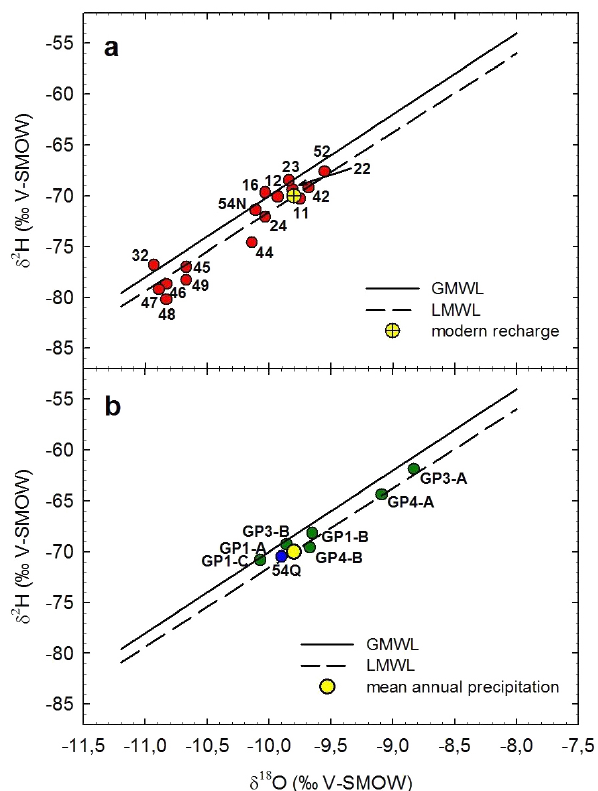
Figure 5. (a) δ 2 H– δ 18 O relationship for groundwater samples rep- resenting the Neogene aquifer, collected in the study area. Mean iso- topic composition of modern recharge of the aquifer is also